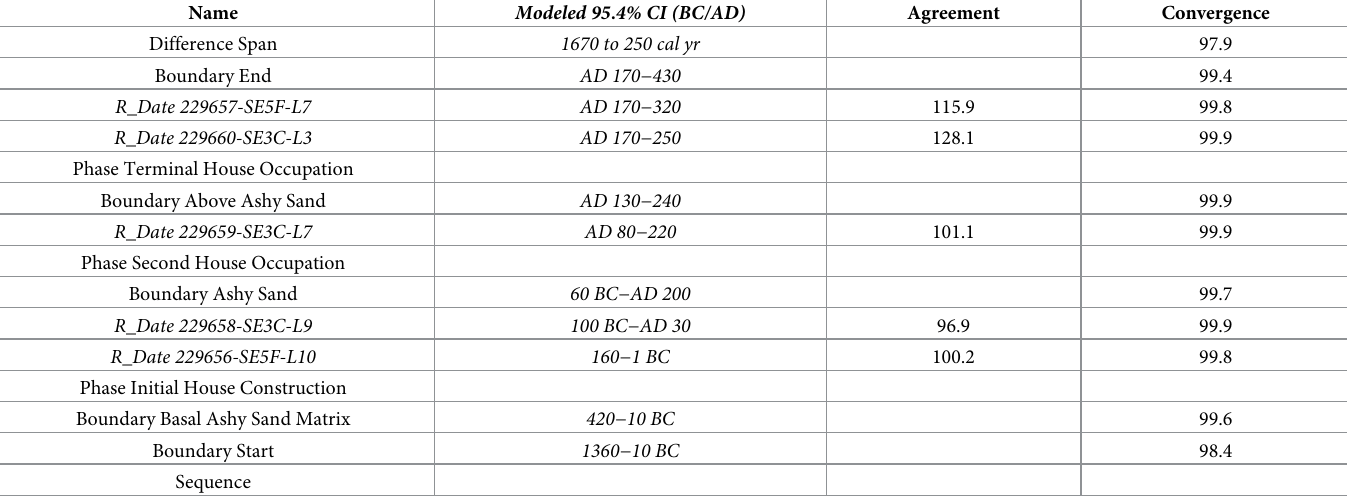
Table 8. The fourth iteration of the Palmrose chronological modeling, including modeled sequence, 95% probability ranges, and boundaries. Model indices: Amo- del = 119.4 and Aoverall =